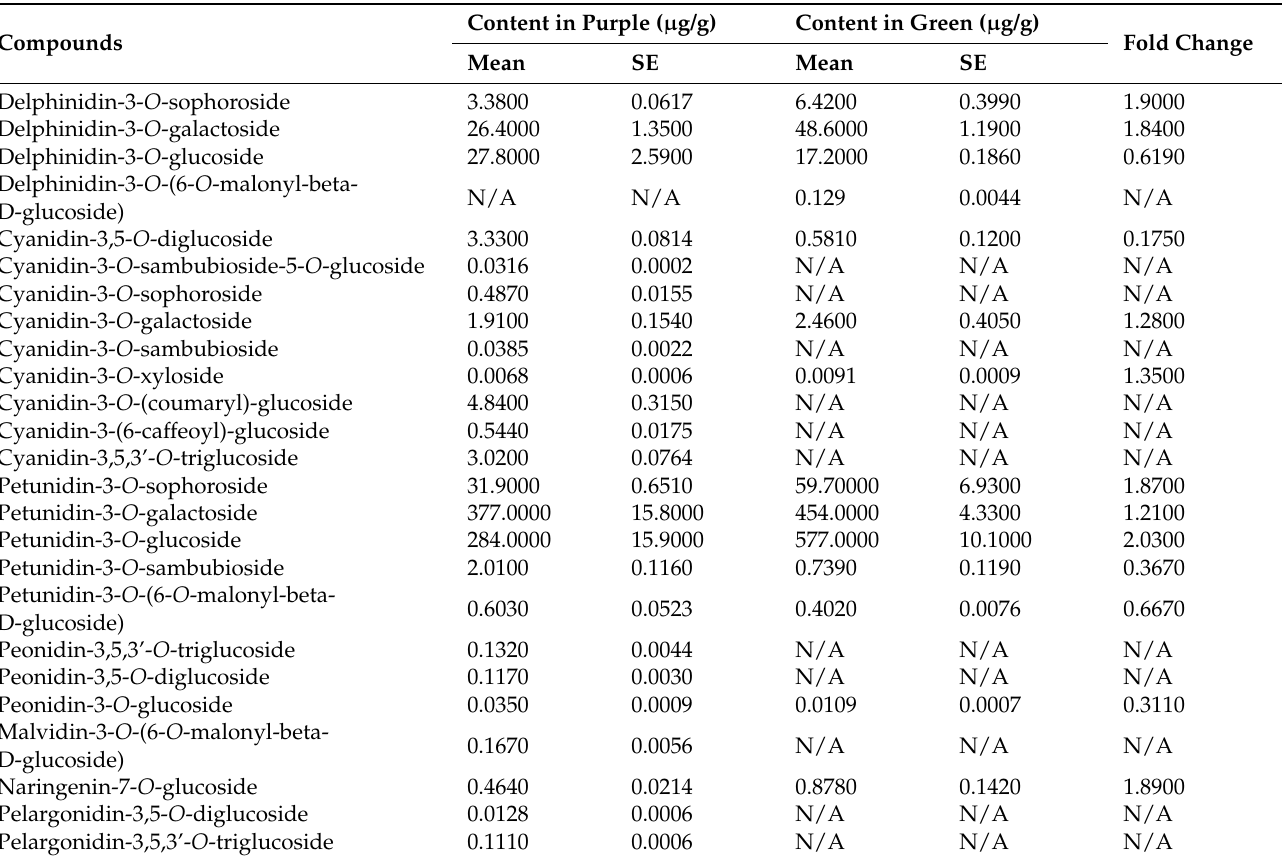
Table 1. The contents of anthocyanin metabolites detected in purple non-heading Chinese cabbage and its green